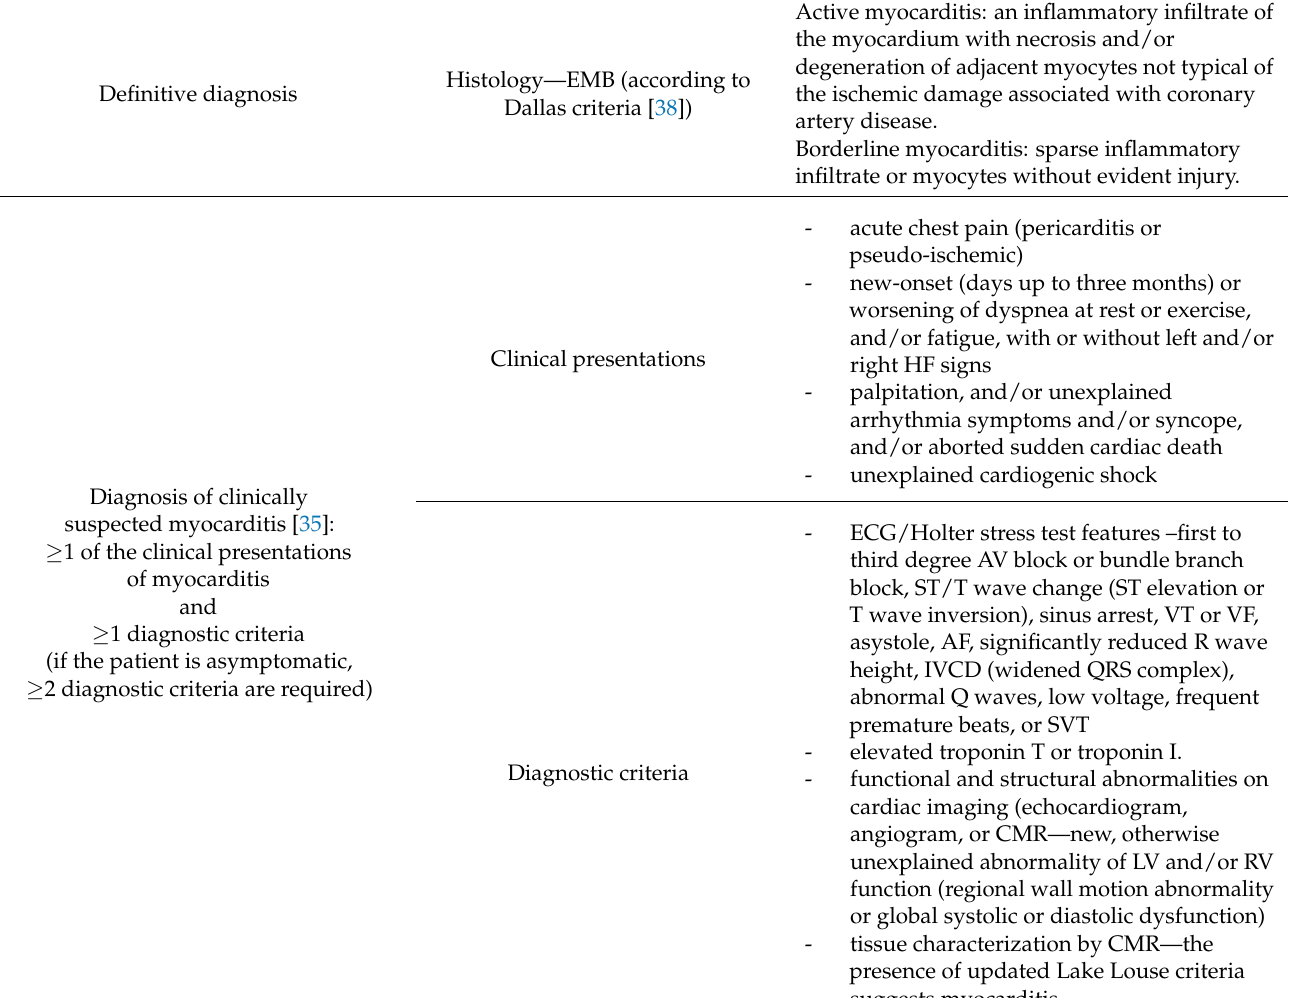
Table 2. Criterias of diagnosis of myocarditis. Based on